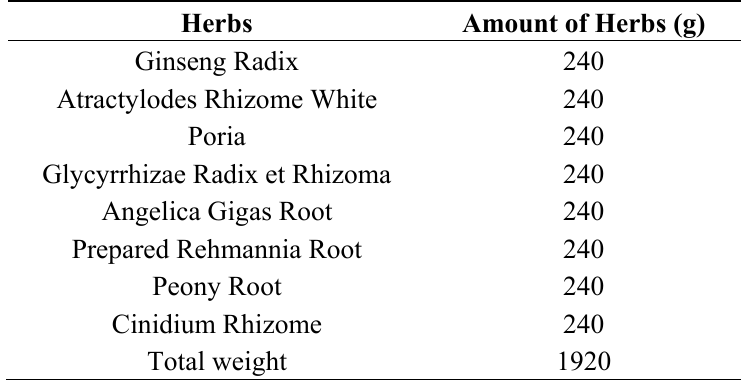
Table 3. Herbal components and amount of Palmultang (PM)